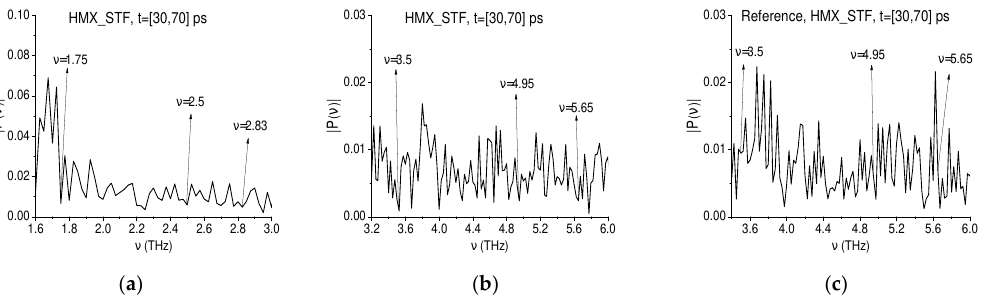
Figure 23. Fourier spectrum of the HMX_STF first sub-pulse in the frequency ranges ν = [1.6, 3.0] THz ( a ) and [3.2, 6.0] THz ( b ). The reference spectrum is depicted in the frequency range ν = [3.2, 6.0] THz ( c ).